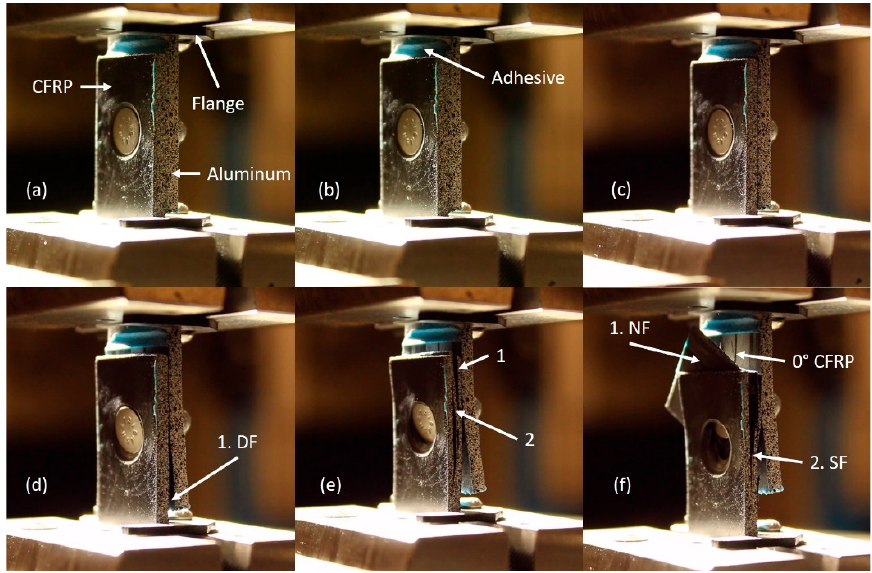
Figure 2. Quasi-static experiment at different time steps of the multi-material bonded/bolted specimen, BT-H03 (overlap length 26 mm and width 18.5 mm), with marked failure modes (DF—delamination failure, SF—shear-out failure, and NF—net tension failure): ( a ) at the beginning of the experiment, ( b ) right before the delamination failure, ( c ) right after the delamination failure, ( d ) after 330 s of the experiment, ( e ) after 515 s of the experiment, and ( f ) at the end of the experiment.